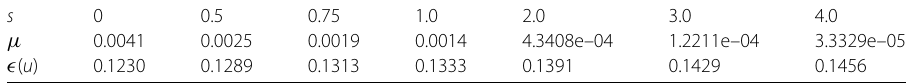
Table 3 At t = 0: α = 1.5, θ = 0, γ = 0.2, ε = 0.01, the relative errors for various s s